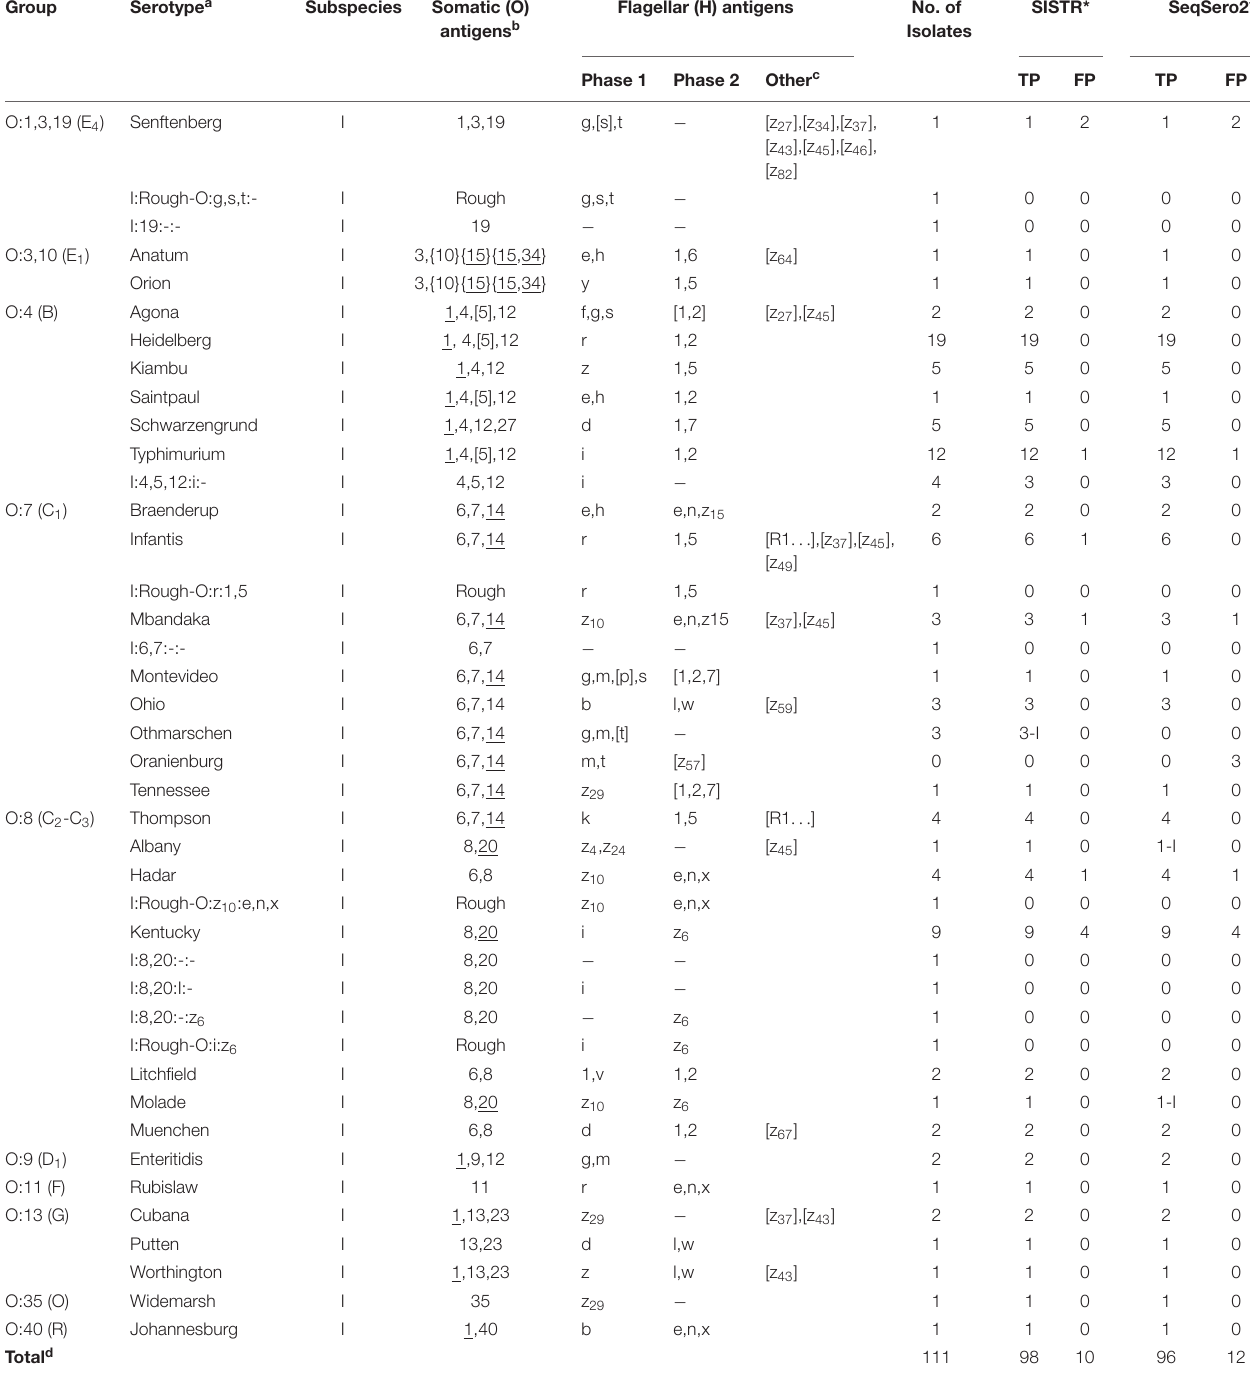
TABLE 5 | Predicting Salmonella serotypes using WGS data. Group Serotype a Subspecies Somatic (O)